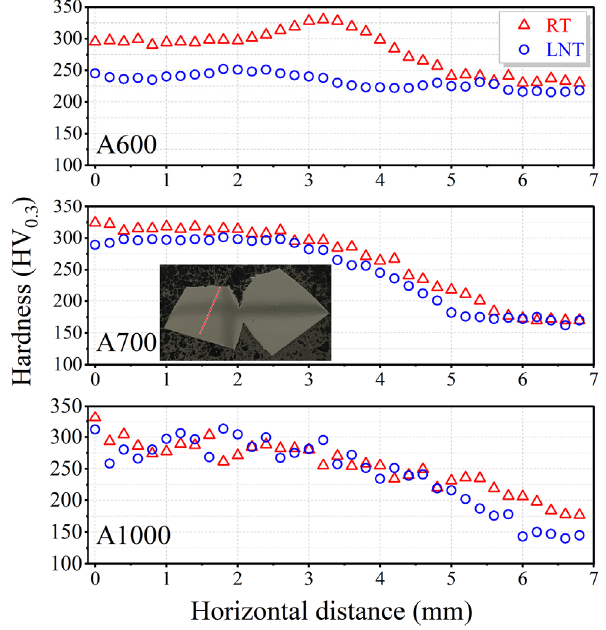
Figure 5. Hardness as a function of depth on intermediate fracture surfaces of Charpy V-notch impact specimens.